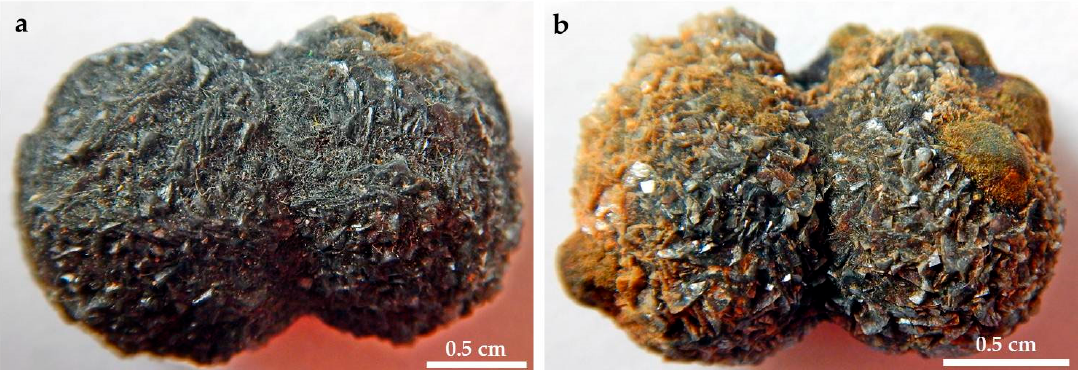
Figure 11. Twin black calcite spheres and related jamesonite “wool” from Herja. a ) Twin black calcite spheres with more abundant jamesonite preserved in the junction zone; sample RCol/2/Q, MMBBU. b ) Twin black calcite spheres formed of flattened calcite rhombohedra associated to jamesonite and covered by siderite minute crystals and attached spheres; sample RCol/2/S; MMBBU.